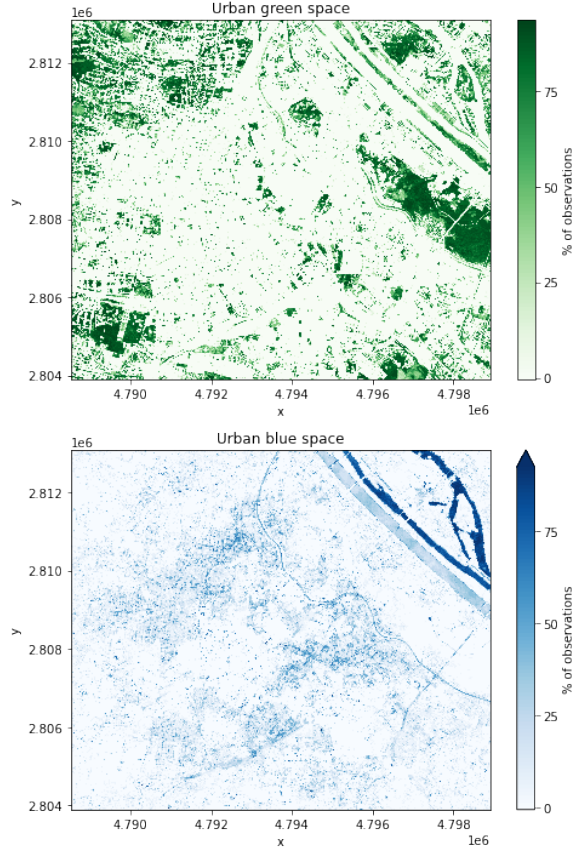
Figure 4. Visualized output of the query